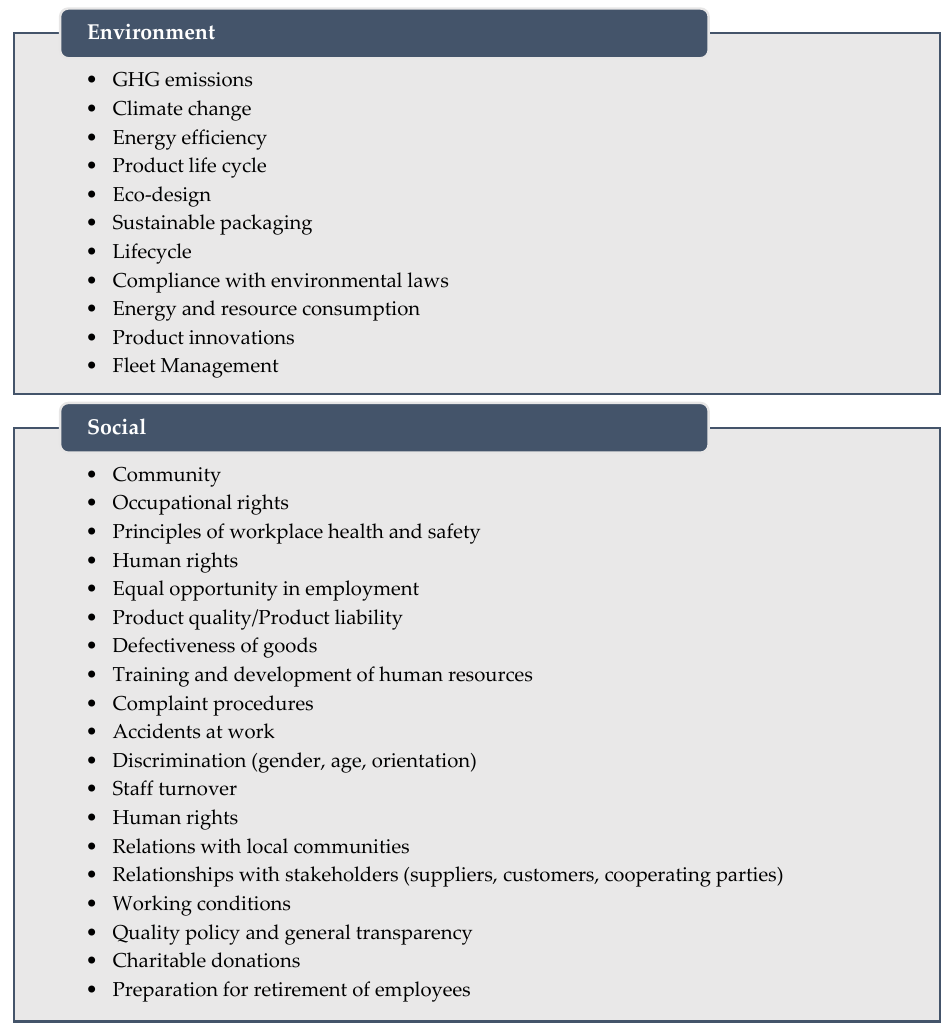
Governance Figure 1. Cont